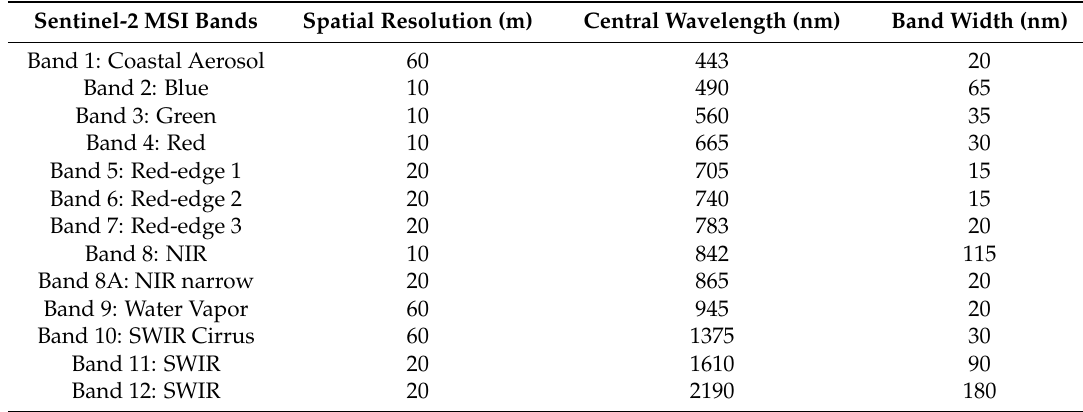
Table 2. Spectral and spatial resolution of the Sentinel-2 MSI